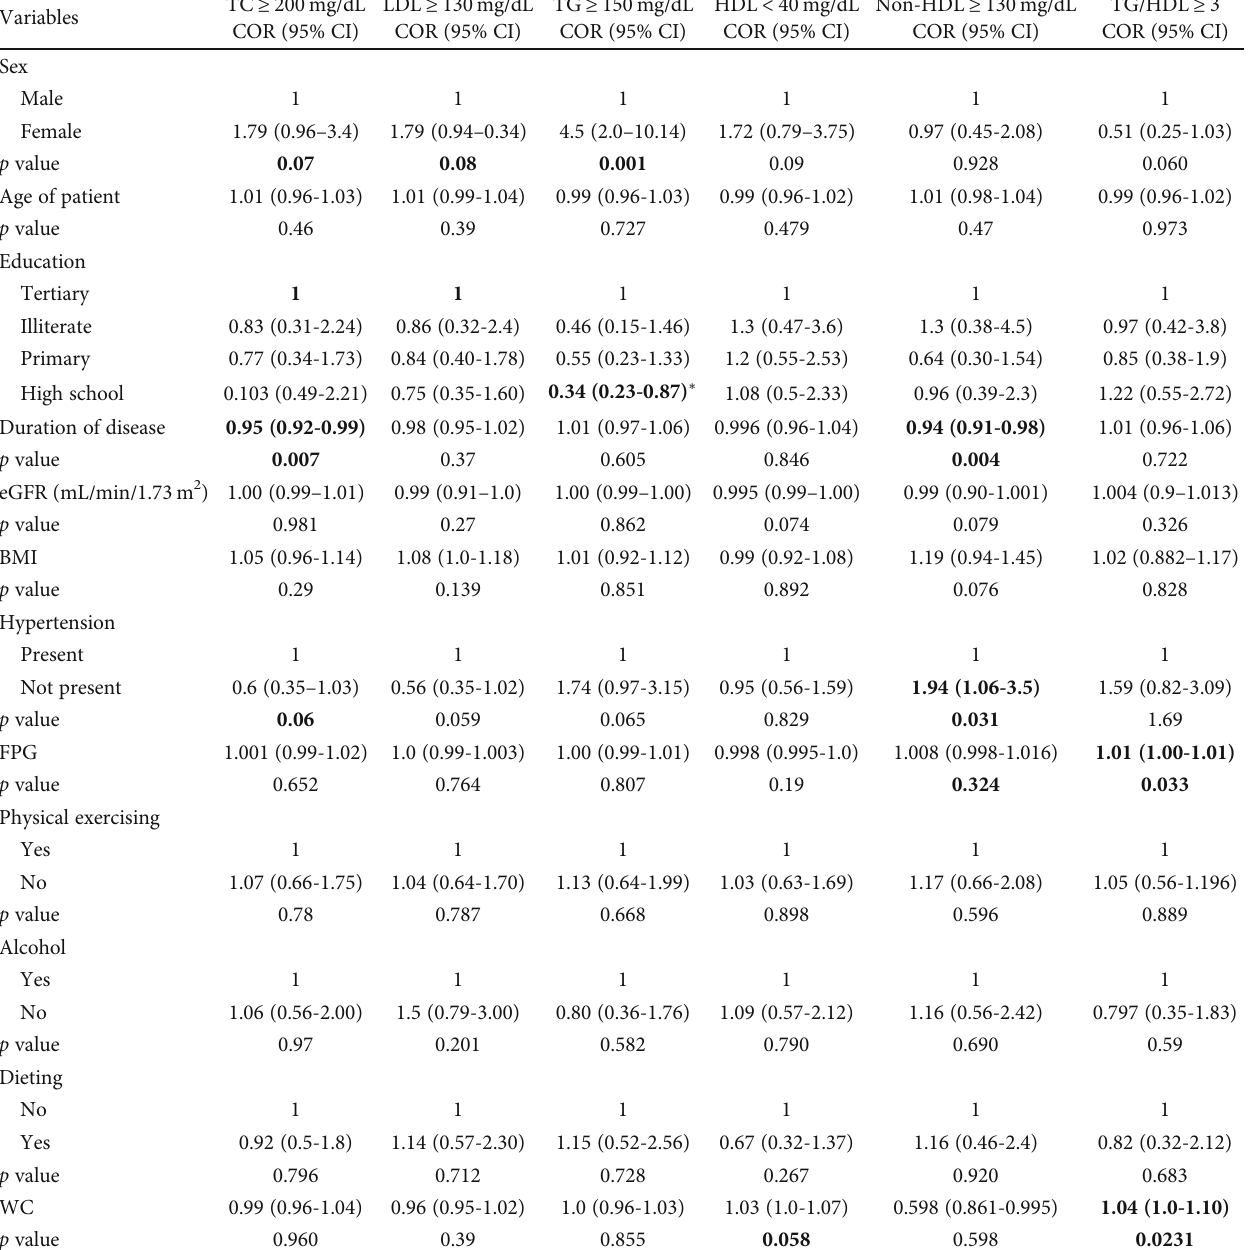
Table 4: Adjusted logistic regression analysis of factors associated with control of speci fi c lipid analytes in DM patients at Halibet Referal Hospital, in Asmara, Eritrea ( n = 309